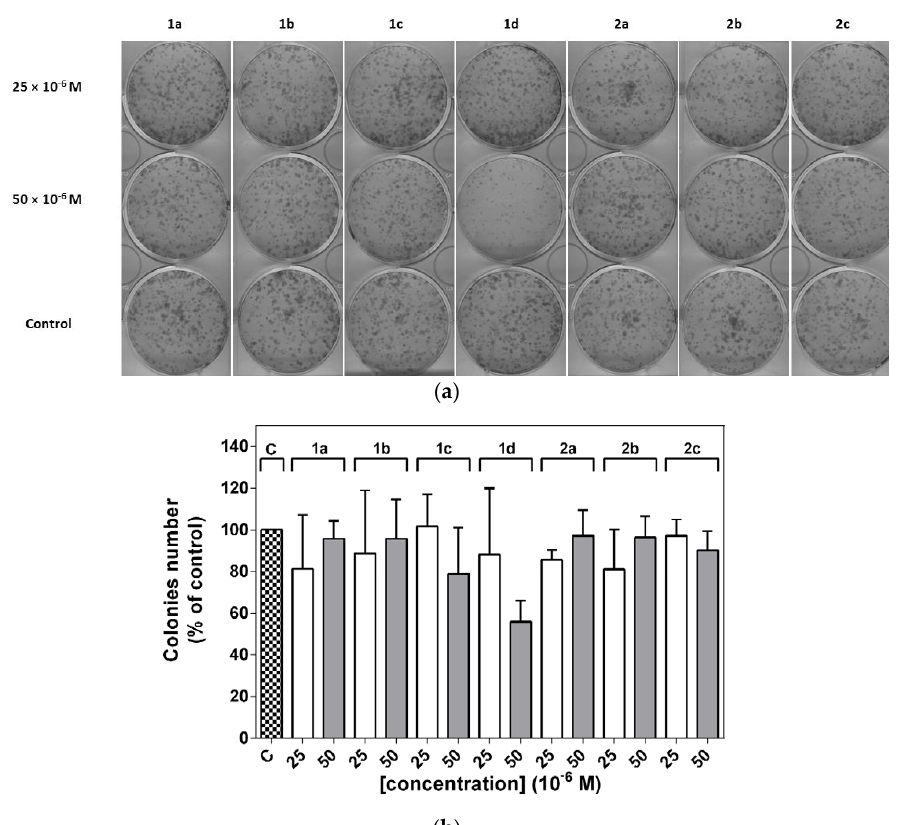
Figure 6. Clonogenic assay of A549 cancer cell lines. Cells were untreated (control) or treated with different concentrations of tacrine-coumarin hybrid derivatives 1a – 2c for 24 h. ( a ) The experimental and ( b ) graphical presentation of the results. The results of the subsequent 7-day cultivation are presented as the mean values ± SD of three independent